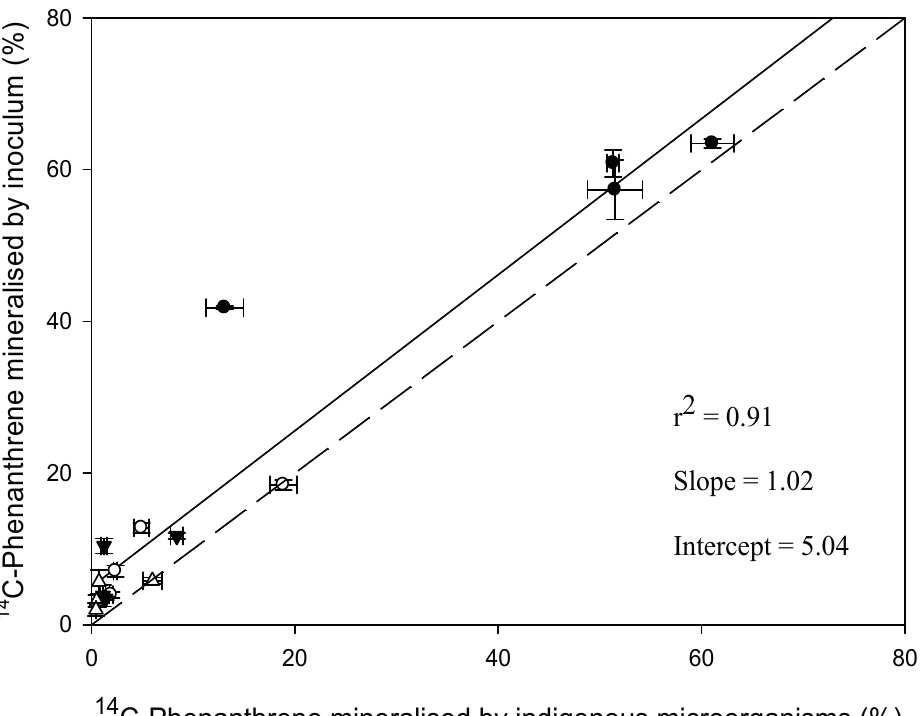
Figure 3. Linear regression showing the correlation between total extents of 14 C-phenanthrene mineralised by an enriched inoculum ( Pseudomonas sp.) and indigenous soil microorganisms. Data points represent both AC-amended and controls soils. Dashed line represents y = x correlation between the two variables. Error bars are SEM ( n = 3). Legend